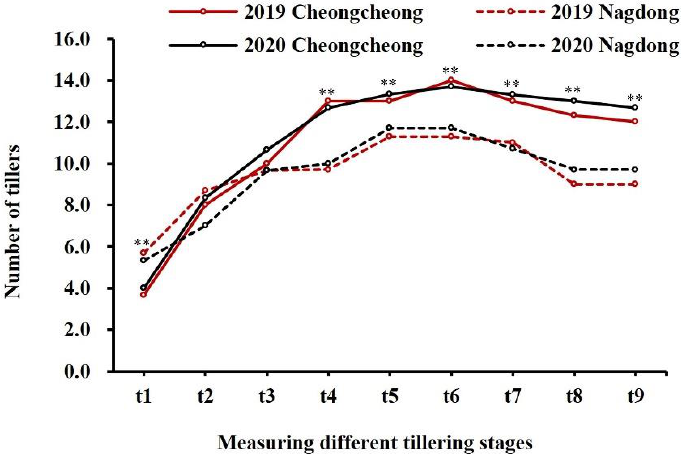
Figure 3. Weekly variation in the tiller number of Cheongcheong and Nagdong. The tiller number of each plant was investigated every 7 days, starting 30 days after planting the seedling into the field (denoted as t1 to t9). Values are means ± SD ( n = 3). ** p < 0.01 (two-tailed Student’s t -test).